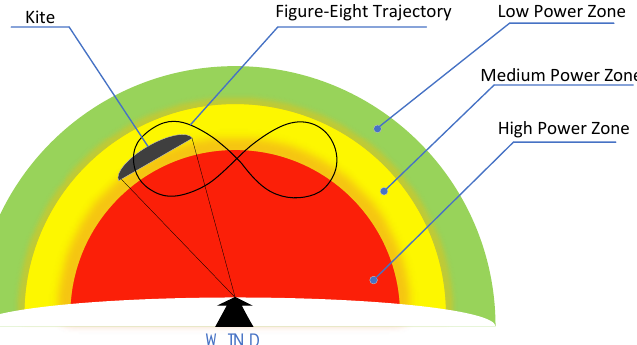
Figure 3. Wind window: an imaginary boundary in which the kite can be flown to produce power; the red area indicates the maximum power zone, the yellow area shows the moderate power zone, and the green area indicates the low power zone.